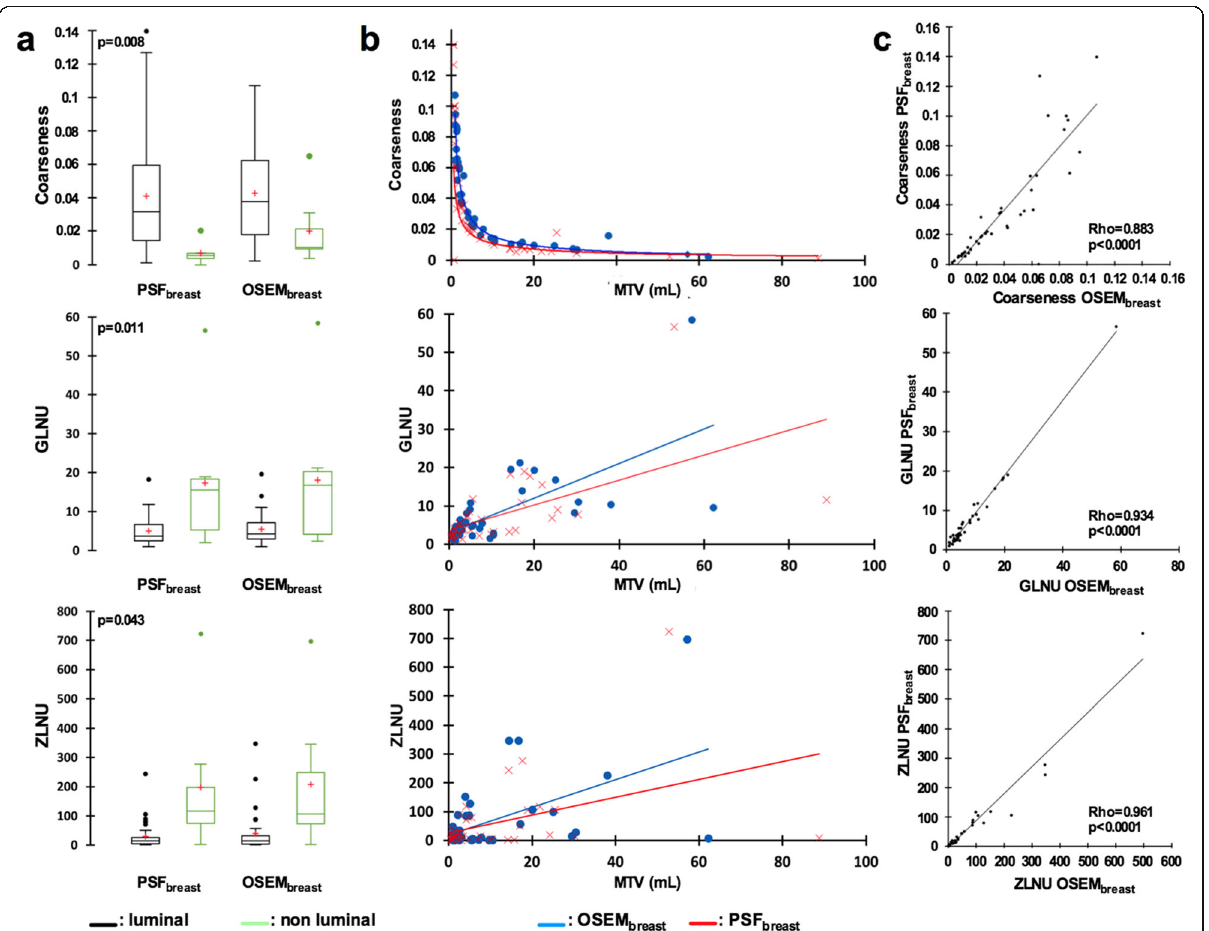
Fig. 4 Comparison of coarseness, GLNU and ZLNU values extracted from PSF breast and OSEM breast images: box plots ( a ) correlation with MTV (ml) ( b ) and correlation between reconstruction protocols ( c ). Red cross in box plots represents the mean values and circle extreme